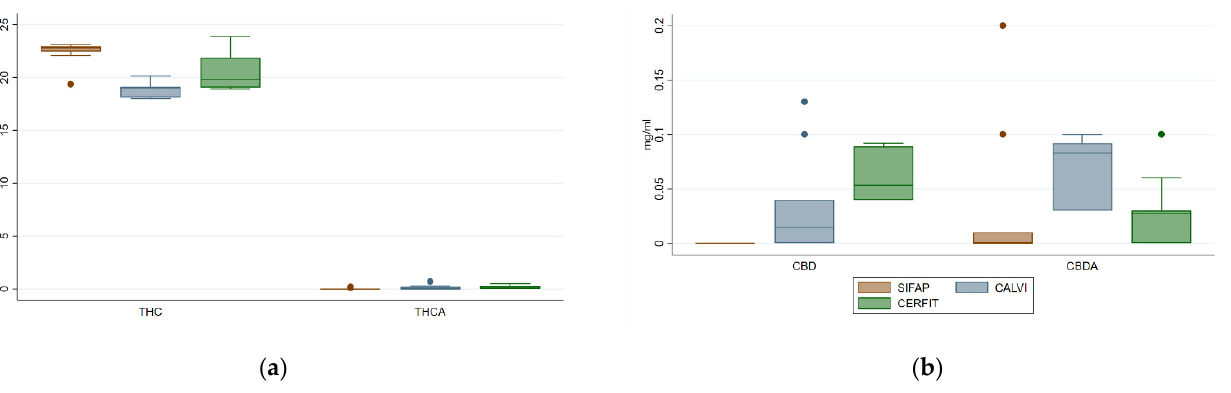
Figure 2. Distribution of concentrations of ∆ 9-THC, ∆ 9-THCA (panel ( a )), CBD and CBDA (panel ( b )) in medical Cannabis oil preparations extracted by three different methods.